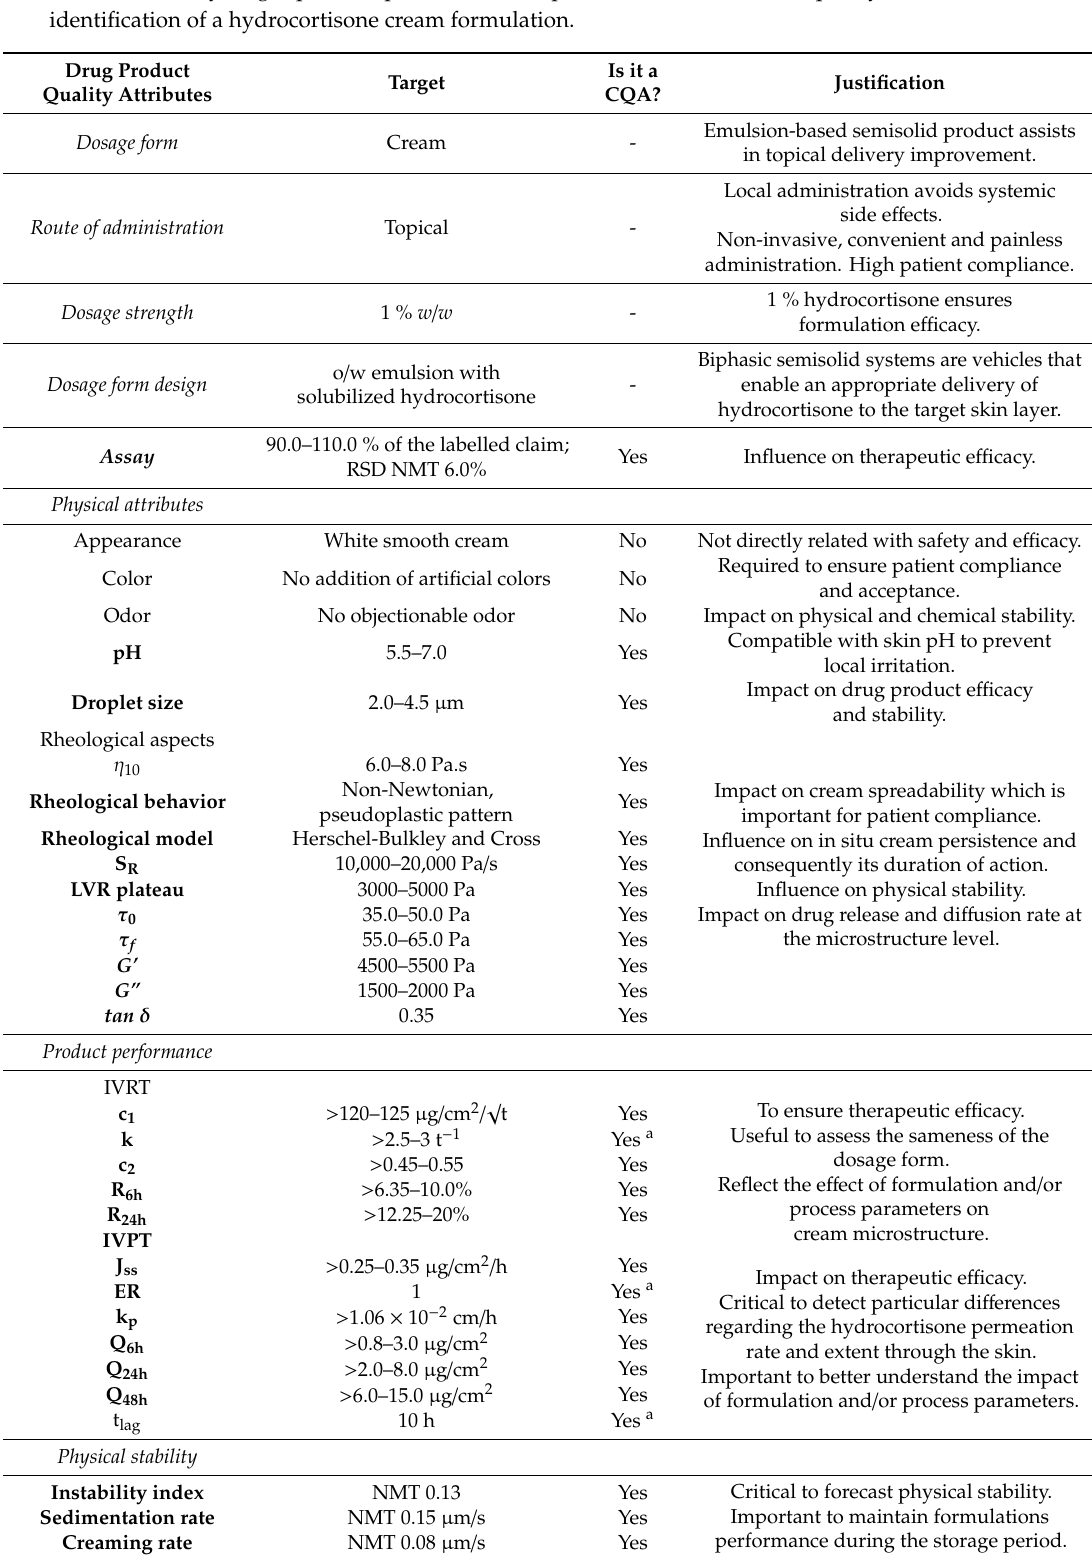
Table 3. Quality target product profile (QTPP) specifications and critical quality attribute (CQA) identification of a hydrocortisone cream